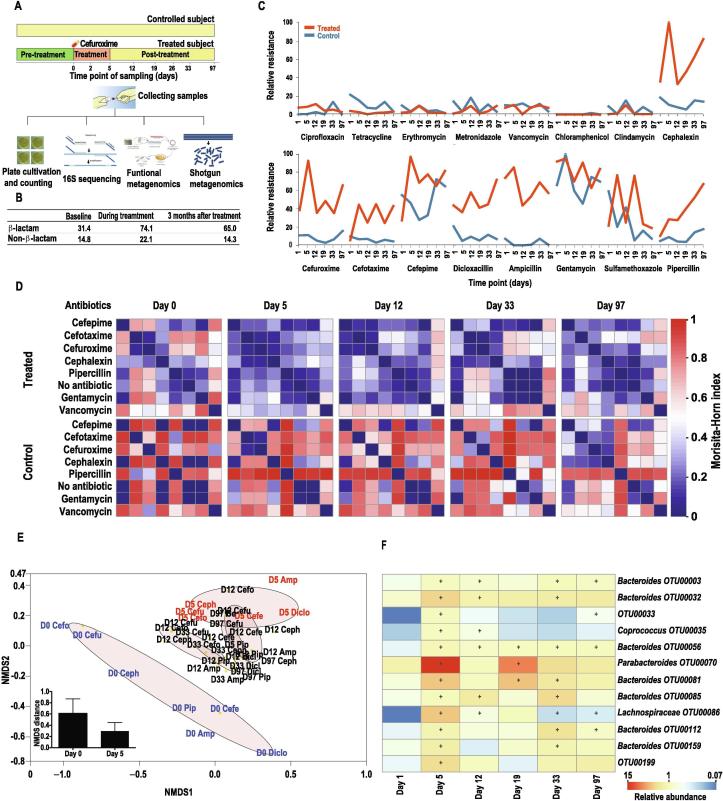
Cefuroxime treatment enhanced the resistance to multiple antibiotics and converged the cultured resistant bacterial communitiesA. Experimental design: Two healthy adult human donors were selected for this study. One subject underwent a standard 5-day treatment with cefuroxime (500 mg, 3 times a day) while the other subject was not treated, serving as a control. Fecal samples from multiple time points were extracted for downstream experiments, including cultivation-based multiplex phenotyping, DNA sequencing of 16S rRNA, and functional and shotgun metagenomics (see Methods for more details). B. Summary of the average percentage resistance levels before, during, and after treatment from both β-lactam and non-β-lactam plates in the treated subject. C. Variation of the relative antibiotic resistance over time in the presence of different antibiotics. D. Heatmap of the pairwise community dissimilarity, as measured by the Morisita–Horn index, across cultivated plates at different time points in the treated and control subjects. Species are in the same order in the vertical and horizontal directions. E. NMDS based on the Morisita–Horn dissimilarity of communities cultured with different β-lactam antibiotics in treated subjects (stress value <0.05). The brown ovals surround the samples from sample time points. Cefo, cefotaxime; Ceph, cephalexin; Cefu, cefuroxime; Pip, pipercillin; Cefe, cefepime; Amp, ampicillin; Diclo, Dicloxacillin. F. Heatmap of antibiotic resistance from β-lactam plates for the species with significantly boosted resistance during treatment. +denotes the resistance is significantly higher (BH adjusted P < 0.01 with permutation test) than that in the baseline sample in the treated subject.